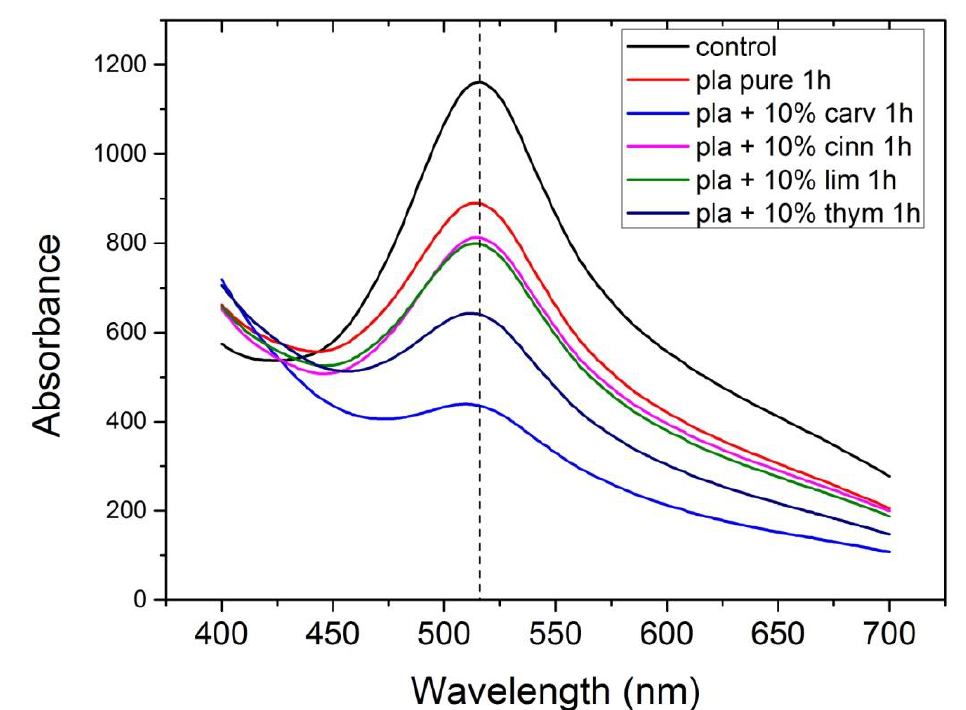
Figure 13. UV spectra of neat PLA and PLA composites with 10% of thymol, carvacrol, limonene and cinnamaldehyde after 1 h in DPPH solution.